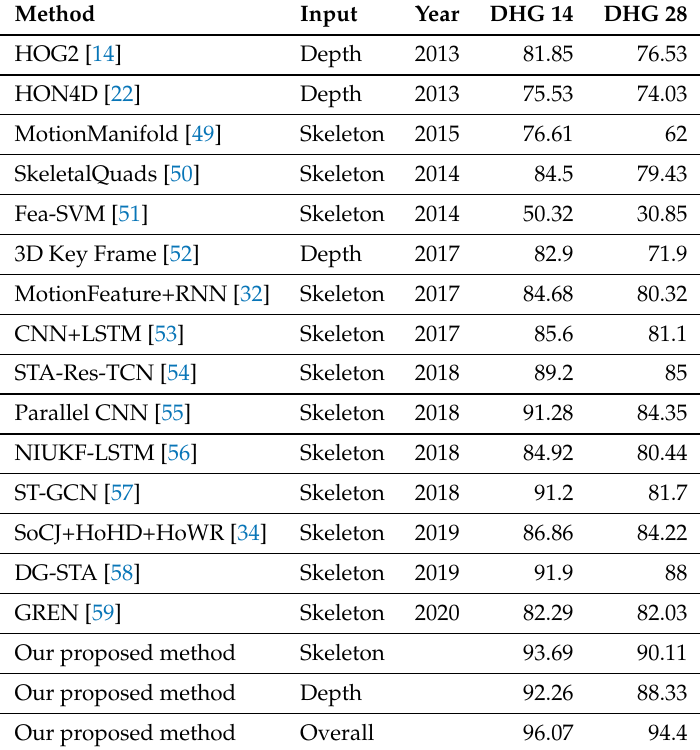
Table 9. Comparison with the related works. SoCJ, Shape of Connected Joints.